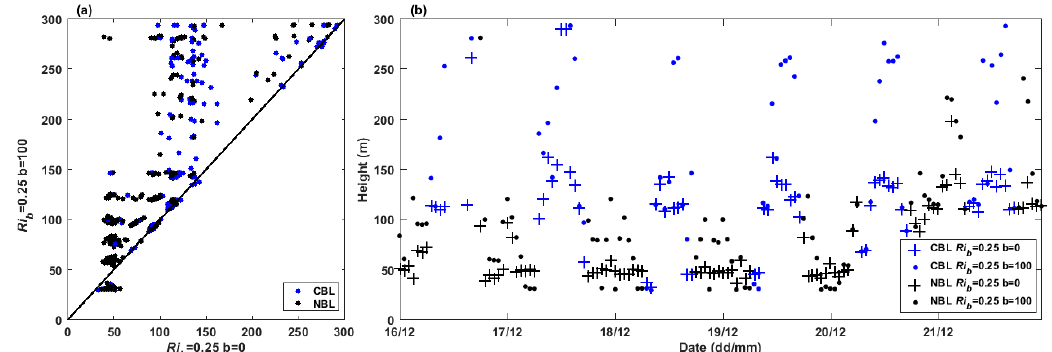
Figure 2. Relationship between the urban boundary layer height (BLH) calculated by using the Ri b method ( Ri b = 0.25) with two di ff erent parameter values, b = 0 and b = 100 for convective boundary layer (CBL) (blue) and nocturnal boundary layer (NBL) (black), during December 2016 ( a ), and the time series values of BLH values from 16 December to 21 December 2016 ( b ), b = 0 ( + ) and b = 100 (dots).